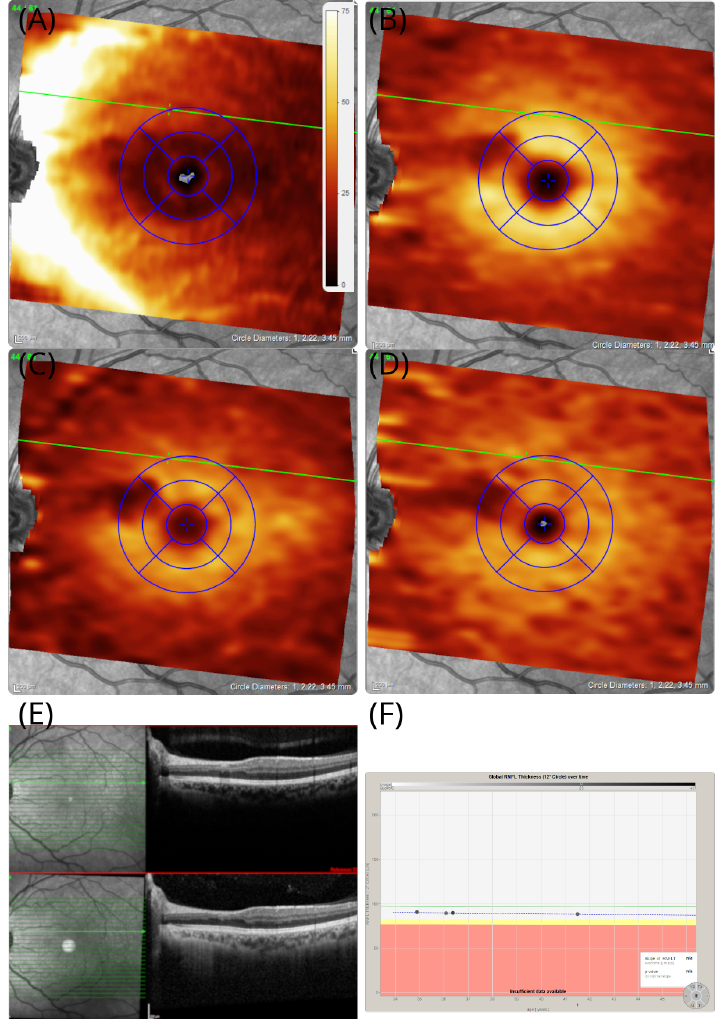
Figure 5. OCT in patient #2 The OCT images of the left eye revealed that an area of localised atrophy of the retinal nerve fibres ( A ) RNFL ( B ) GCL, ( C ) IPL, and ( D ) INL remains preserved. The area of atrophy stretches from the temporal optic disc margin to the macular, which corresponds with the macular arcuate scotoma on the Amsler chart in Figure 4B. ( E ) In addition to the volume-scan thickness maps presented here, B-scans are shown from baseline (red frame) and 7-year follow-up. ( F ) Except for the sectorial atrophy of the RNFL in subfigure ( A ), there is no evidence for pRNFL atrophy elsewhere, which remained stable across the 7-year observation period.